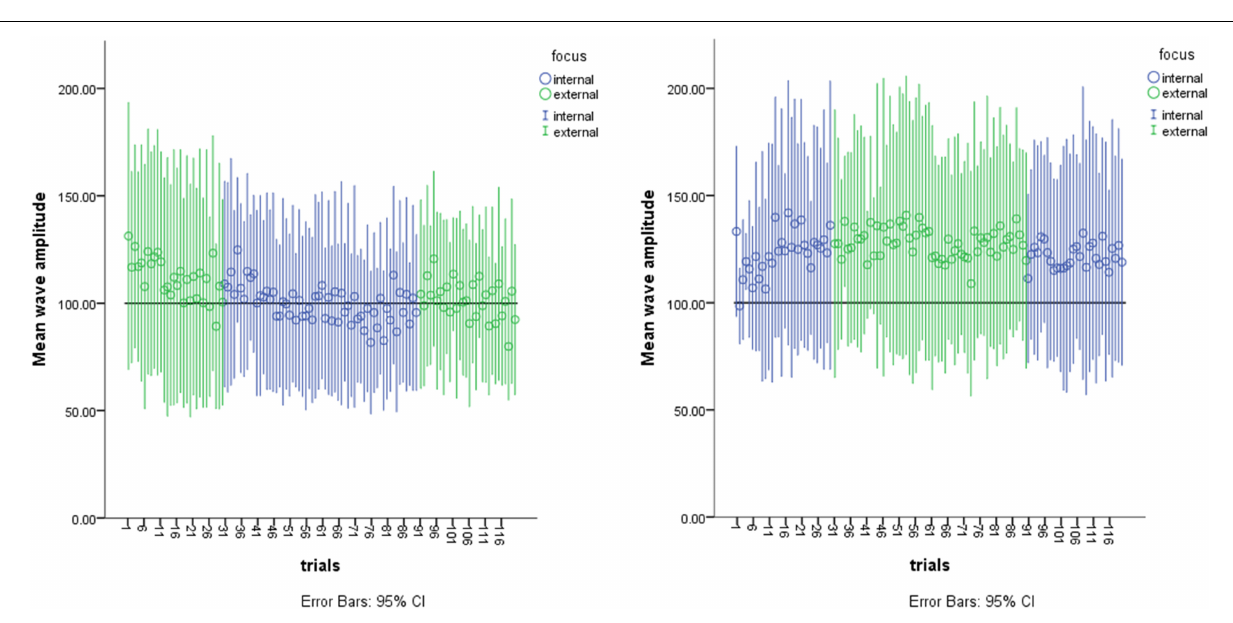
FIGURE 3 | Sequential Effects on mean wave amplitudes of Instruction type and trials. The left-hand graph shows the data of the participants who performed the ABBA sequence where A = External Focus of Attention and B = Internal Focus of Attention. The right-hand graph shows the data of the participants who performed the BAAB